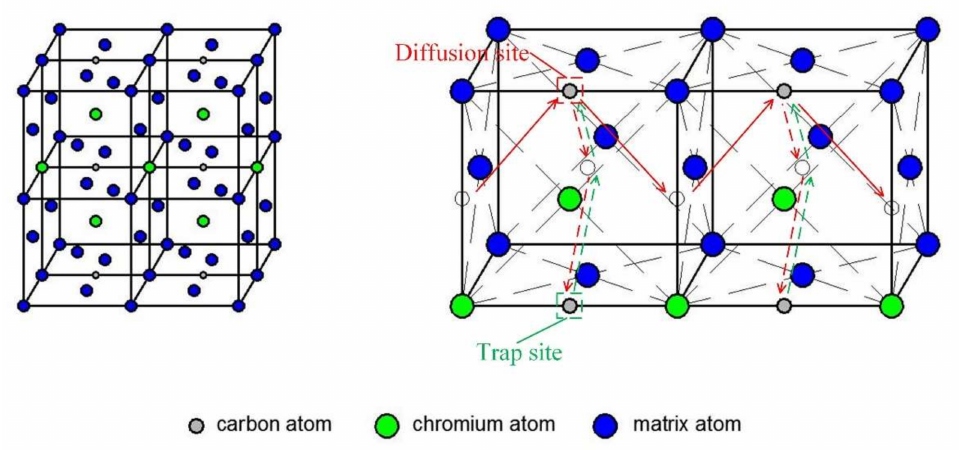
Figure 1. Schematic of the possible crystal structure of carbon expanded austenite and the diffusion paths of carbon in expanded